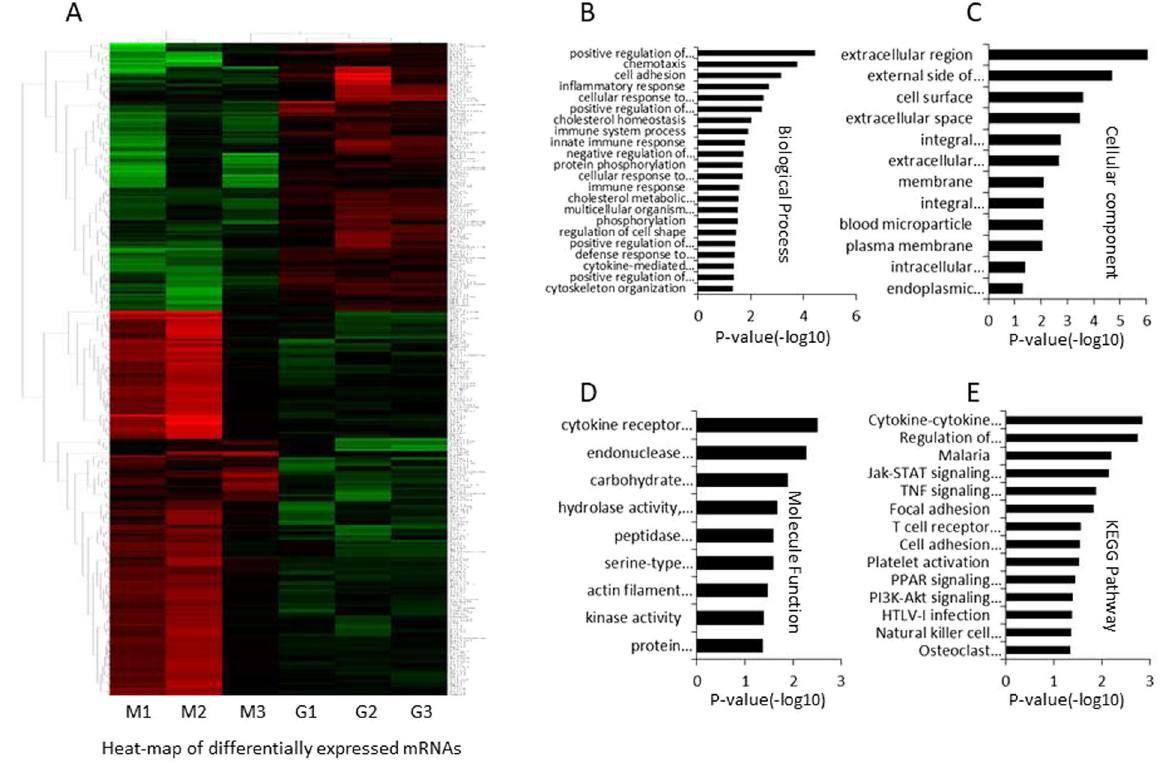
Figure 4. The differential expressed mRNAs were identified between the GLE treated and untreated Hepa1- 6-bearing C57 BL/6 mice. ( A ) Heat-map of DE mRNAs between GLE treated and untreated Hepa1-6-bearing C57 BL/6 mice. The red color represents up-expression of mRNA and green color represents down-expression of mRNA. The relationship among the samples was divided by binary tree classification and was shown at the upper portion. Hierarchical cluster of mRNAs were displayed at nearside. ( B – D ) GO (Gene Ontology) terms in differentially expressed mRNAs. ( E ) KEGG pathways in differentially expressed